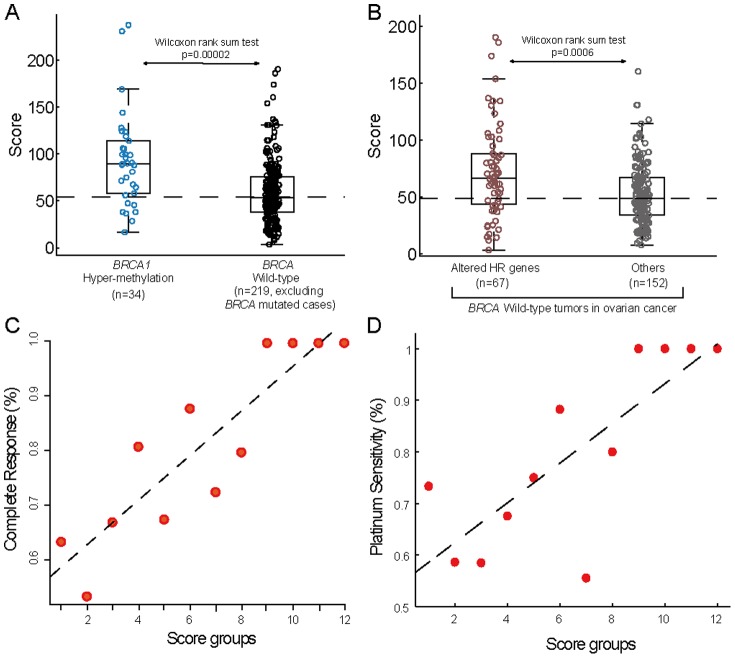
Association of the genomic instability score with HR-deficiency and platinum-response in ovarian cancer.(A) The distribution of score in BRCA1 hyper-methylated patients is significantly higher than that in BRCA wild-type patients. (B) The distribution of score in HR-deficient patients (including EMSY amplification cases, and PTEN, Fanconi Anemia genes, RAD genes, ATM, ATR and CHEK1/2 deficient cases) is significantly higher than that in other BRCA wild-type patients. (C) Association of the score with complete response (CR). The scores of all patients (n = 325) were divided into 12 equal intervals. The percentage of patients achieving a CR (according to the Response Evaluation Criteria in Solid Tumors) was calculated for patients in each interval and was plotted against each scoring interval in increasing order. Patients in high scoring interval show increasing likelihood of achieving CR. The dashed line represents linear regression line through the data points. (D) Same as (C) but calculating for platinum-status. 133 platinum-sensitive patients and 62 platinum-resistant patients were analyzed.